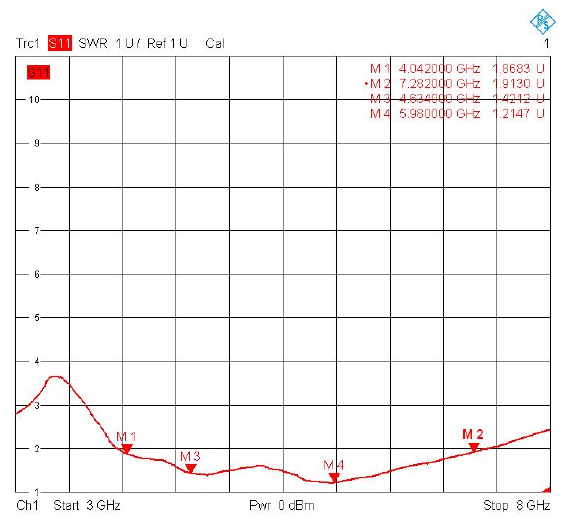
Figure 10. Variation of measured VSWR with frequency for pro- posed geometry